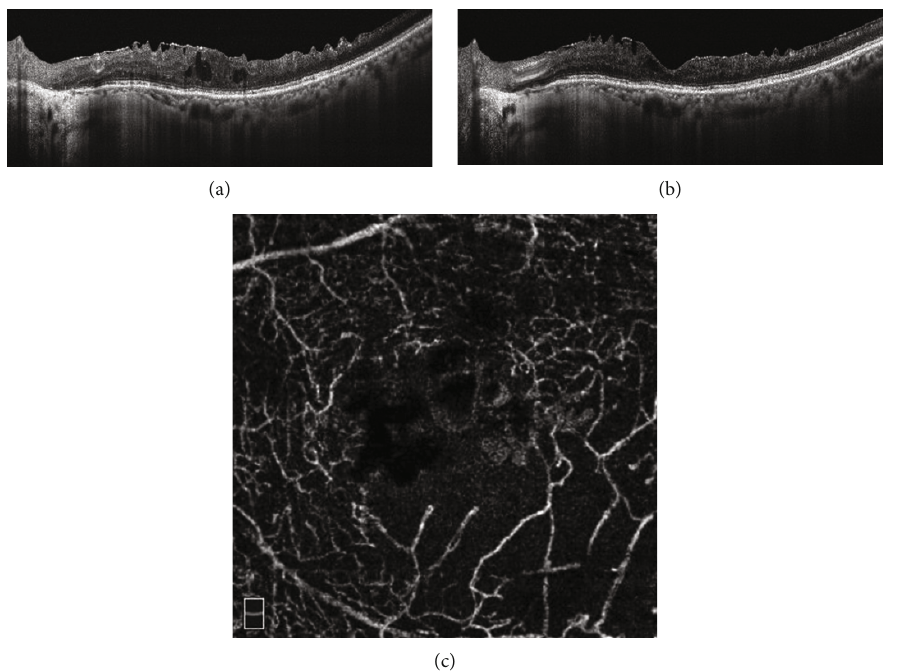
Figure 4: A 55-year-old male had an eGFR of 3.8. (a) At baseline, there was macular edema with intraretinal cysts involving fovea in the left eye. (b) At month 12, the macular edema improved a lot after 6 ranibizumab injections were given, while the vision did not improve. (c) OCTA showed severe ischemia at parafoveal areas.